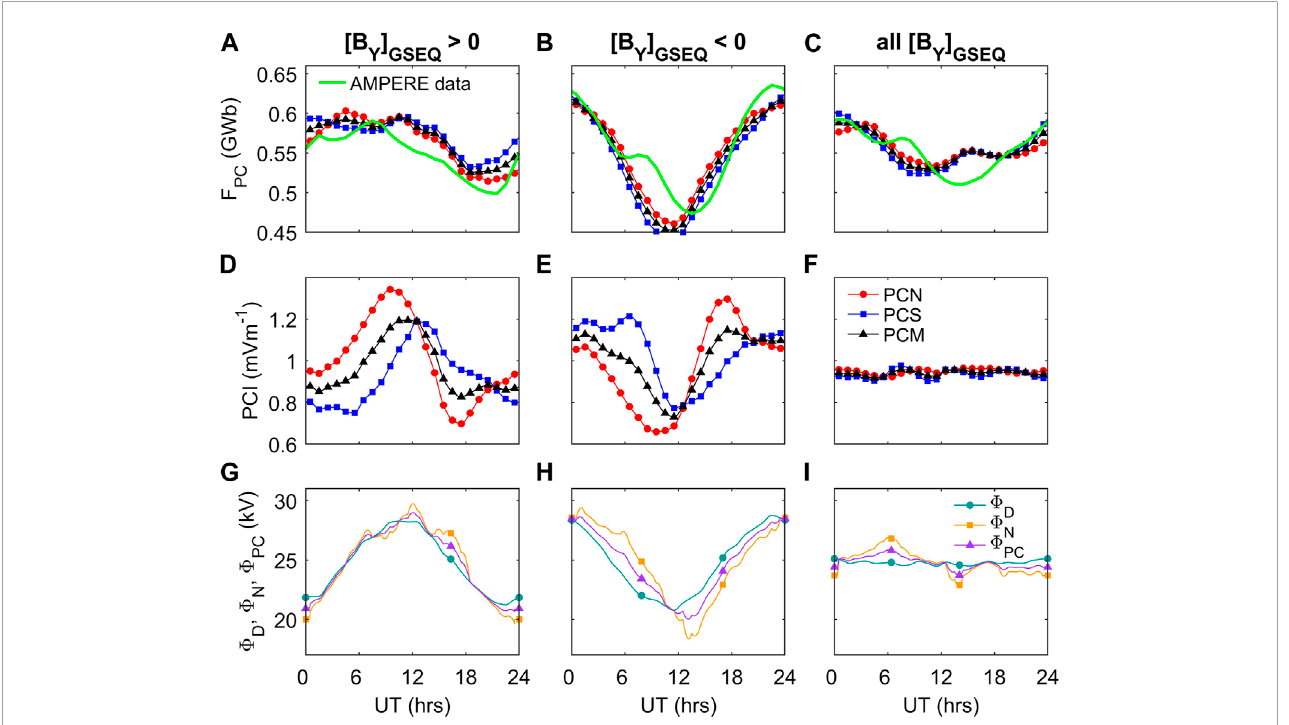
FIGURE 20 Analysis of UT variations in reconnection rates and the expansion and contraction of the polar cap. The top row shows the estimated variations of the polar cap flux F PS from the AMPERE field-aligned current data (in green), and from the DMSP convection data for the Northern hemisphere (in red with circle symbols) and the Southern hemisphere (in blue with square symbols). The model shows the Polar Cap Index variations presented in the right hand column of Figure 11 , but this time comparing PCN , PCS and PCM for one IMF [ B Y ] GSEQ classification. The bottom row shows the variations in the estimations of magnetopause reconnection voltage Φ D (green with circle symbols), cross tail current sheet voltage Φ N (orange with square circles) and the transpolar voltage Φ PC (mauve with triangle symbols). The left-hand column is for [ B Y ] GSEQ > 0, the middle column for [ B Y ] GSEQ < 0 and the right-hand column for all [ B Y ] GSEQ